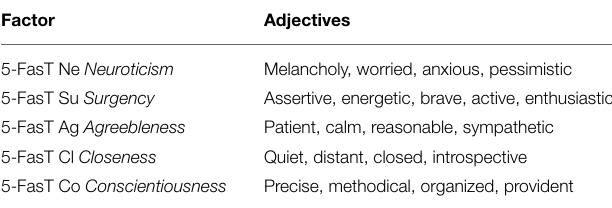
TABLE 1 | 5-FasT factors.